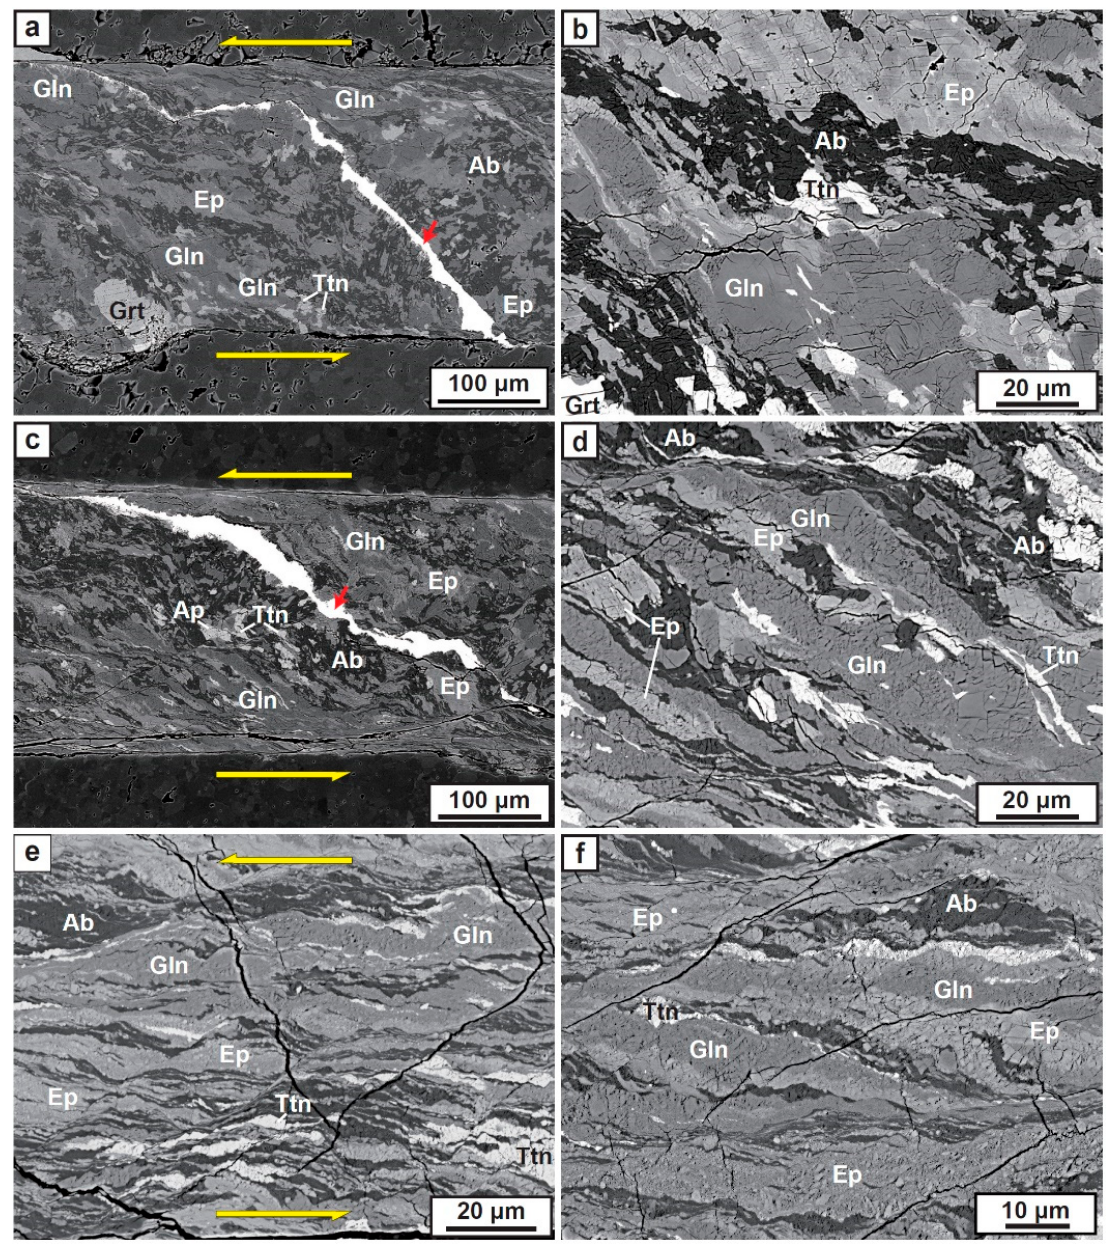
Figure 3. BSE images of deformed samples after simple shear experiments. ( a , b ) sample deformed with low shear strain (JH88b, γ = 0.8, P = 1.5 GPa, and T = 400 °C); ( c , d ) sample deformed with intermediate shear strain (JH94b, γ = 1.5, P = 1.5 GPa, and T = 400 °C); ( e , f ) sample deformed with high shear strain (JH94a, γ = 4.5, P = 1.5 GPa, and T = 400 °C). Long yellow arrows indicate the left-lateral (sinistral) shear sense, and red arrows indicate the Ni strain marker. All samples in the images show the left-lateral (sinistral) shear sense. Gln: glaucophane, Ep: epidote, Ttn: titanite, Ab: albite, Chl: chlorite, Grt: garnet, and Ap: apatite; P: pressure; T = temperature.